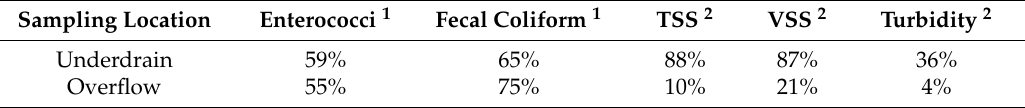
Table 5. Percent reduction of mean from inlet for each pollutant from surface and underdrain